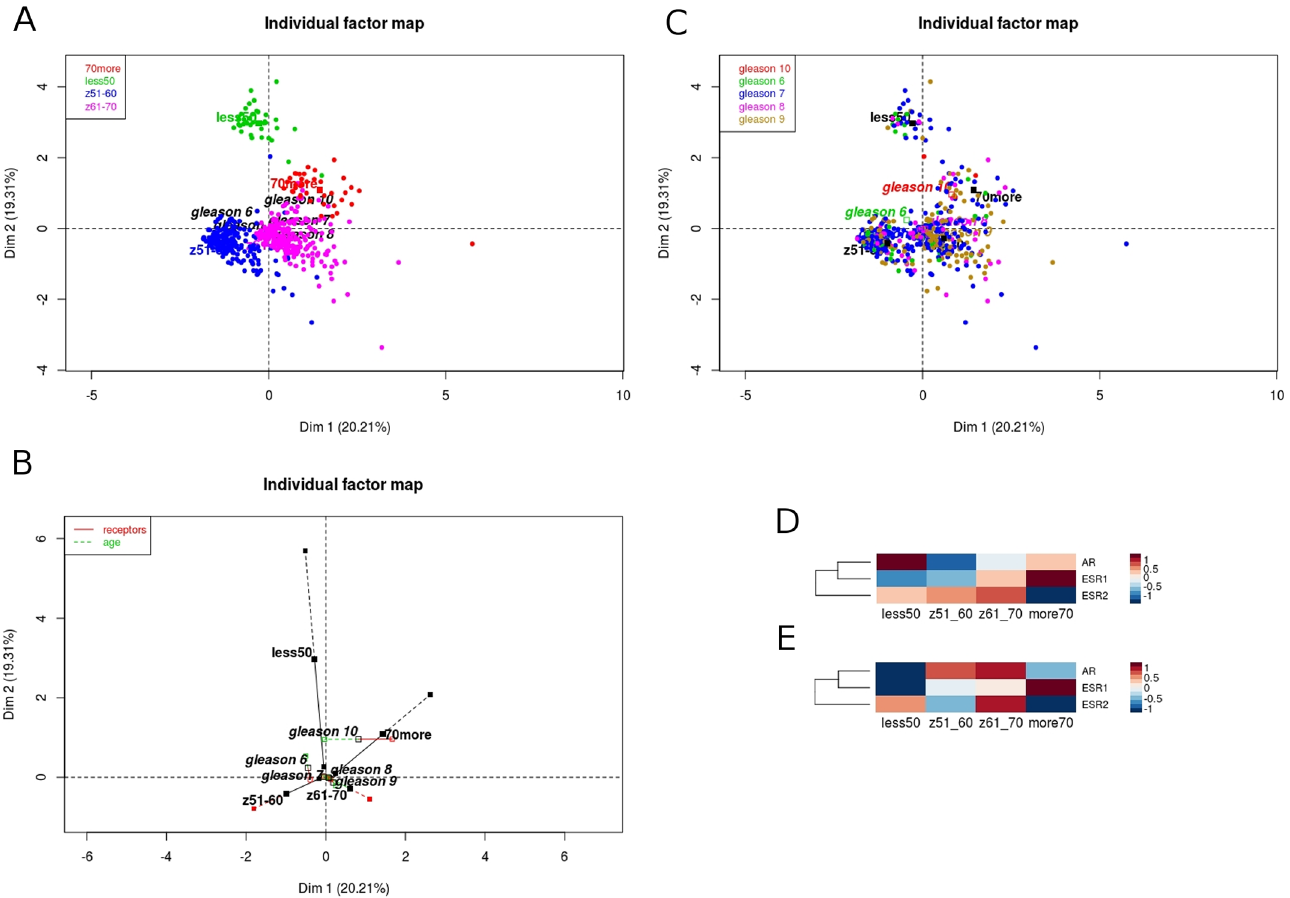
Fig 1. Characteristics of PRAD patients are related to AR , ESR1 and ESR2 expression, and patient’s age. The expressionof AR , ESR1 and ESR2 indicatespartition of PRAD cases into patients age (A), howeverno associationsin Gleason score (B). The projectionsalong Dim2 show distinct groupingof patients aged (cid:20) 50 years old accordingto hormonereceptors expressionand shift of partitioningof patients of 70 > years old along Dim1 (C). Differential expressionof particularreceptors: shift from high expressionof A R in the youngestpatients towards high expressionof ESR1 in the oldest within tumor samples(D) and lower AR expression, but no differences in the expressionof both estrogen receptors in matched, adjacent normal samples (E).